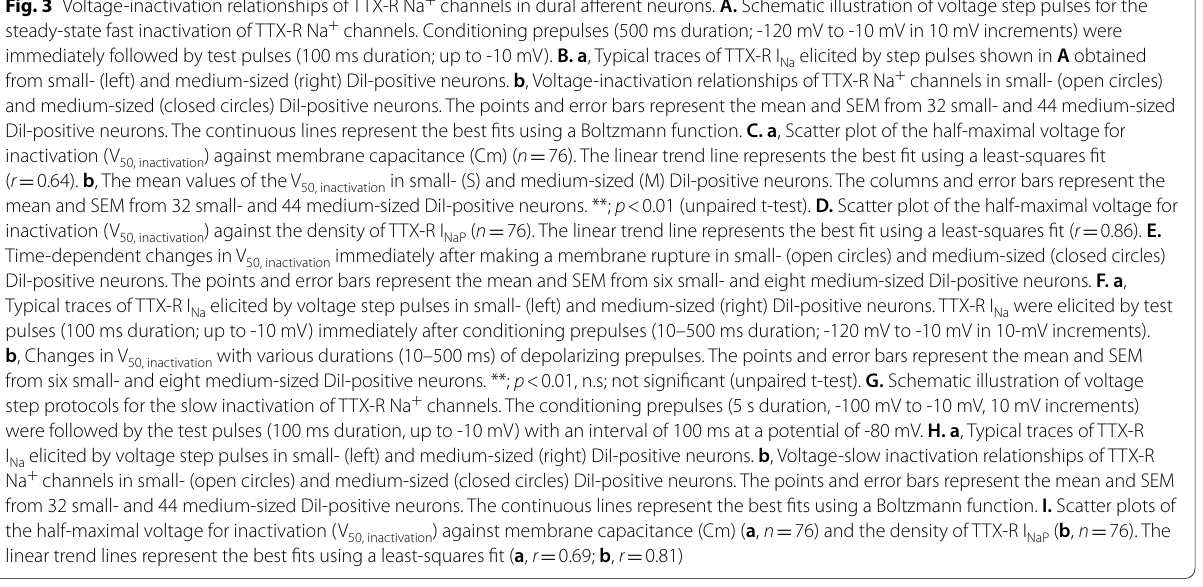
normalized to the maximal current recorded at a pre- pulse of -100 mV, and the data were fitted to the Boltz- mann function (Fig. 3Hb). The V 50,inactivation values for slow inactivation were significantly lower in small- sized neurons than those in medium-sized neurons,